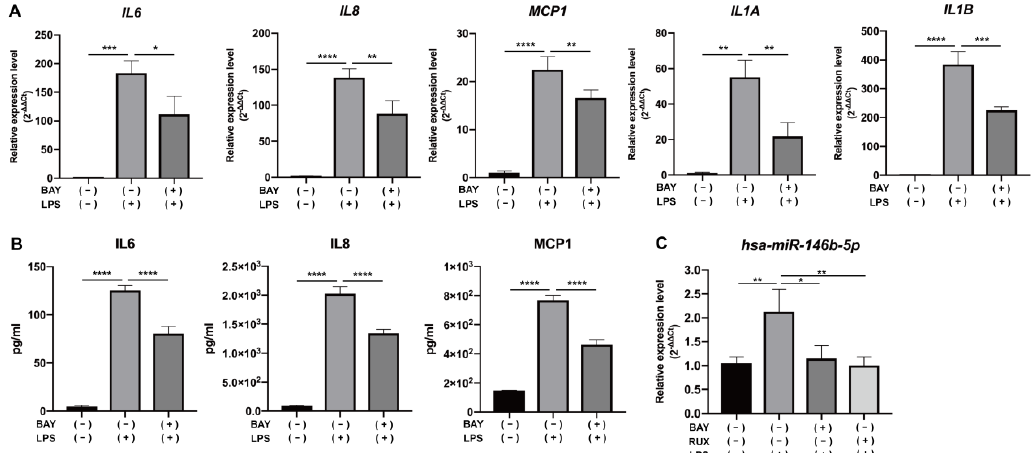
Figure 2. NF- κ B signaling is involved in the expression of hsa-miR-146b-5p and pro-inflammatory mediator mRNAs in LPS-stimulated hDPCs, and JAK/STAT3 signaling is also involved in the expression of hsa-miR-146b-5p. ( A ) mRNA expression of IL6 , IL8 , MCP1 , IL1A , and IL1B was up-regulated by LPS stimulation at 6 h and was abolished by NF- κ B inhibitor BAY 11-7085 in hDPCs (mean ± SD, n = 4). ( B ) Protein expression of IL6, IL8, and MCP1 was up-regulated by LPS stimulation at 6 h and was down-regulated by BAY 11-7085 in hDPCs (mean ± SD, n = 4). ( C ) Expression of hsa-miR-146b-5p was up-regulated by LPS stimulation at 6 h and was down-regulated by BAY 11-7085 or JAK1/2 inhibitor ruxolitinib in hDPCs (mean ± SD, n = 3). * p < 0.05, ** p < 0.01, *** p < 0.001, and **** p < 0.0001. LPS: lipopolysaccharide; hDPCs: human dental pulp cells; BAY: BAY 11-7085; RUX: ruxolitinib.